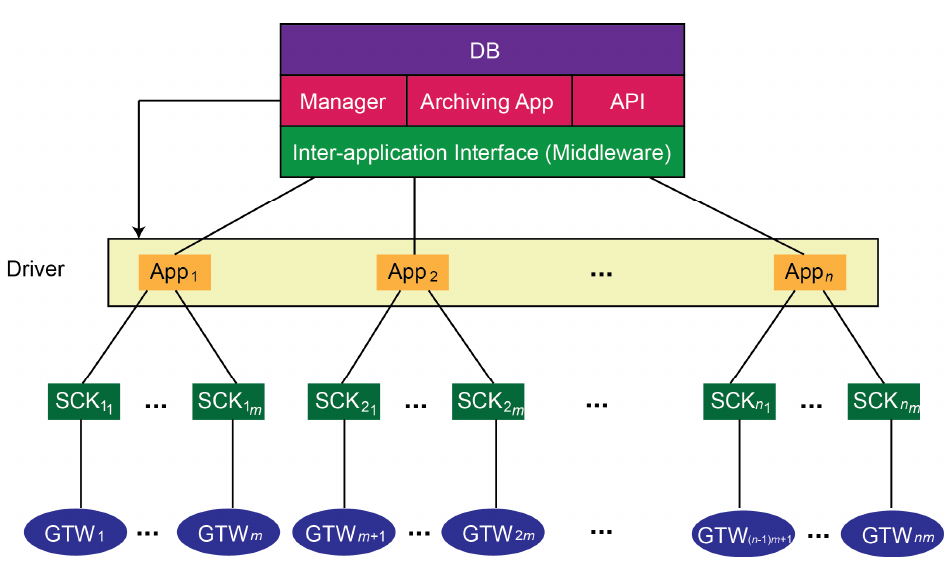
Figure 39. Scalable software architecture.